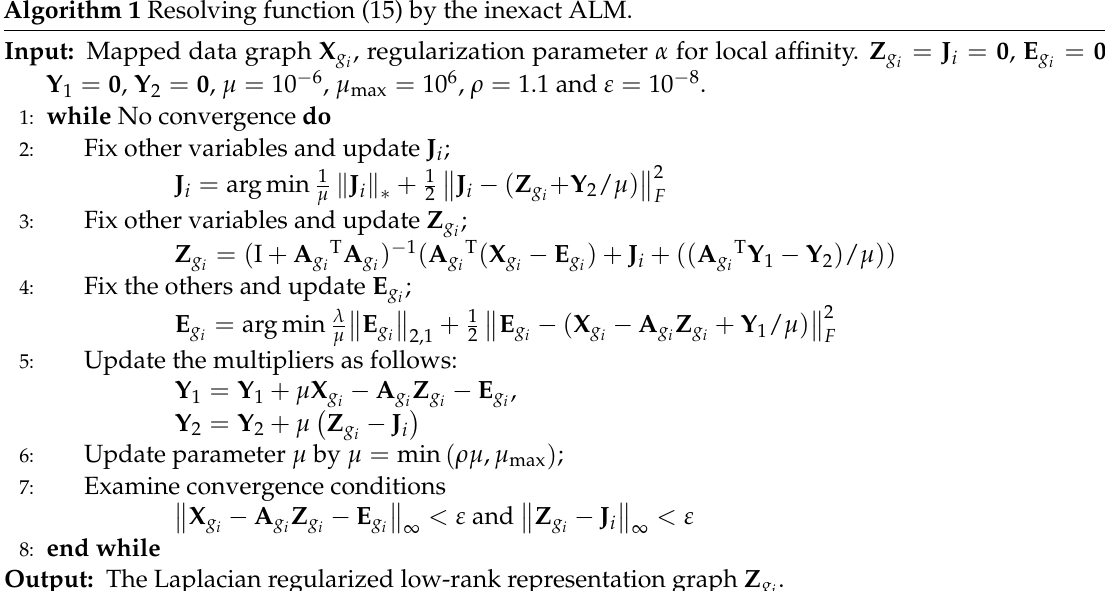
Algorithm 1 Resolving function (15) by the inexact